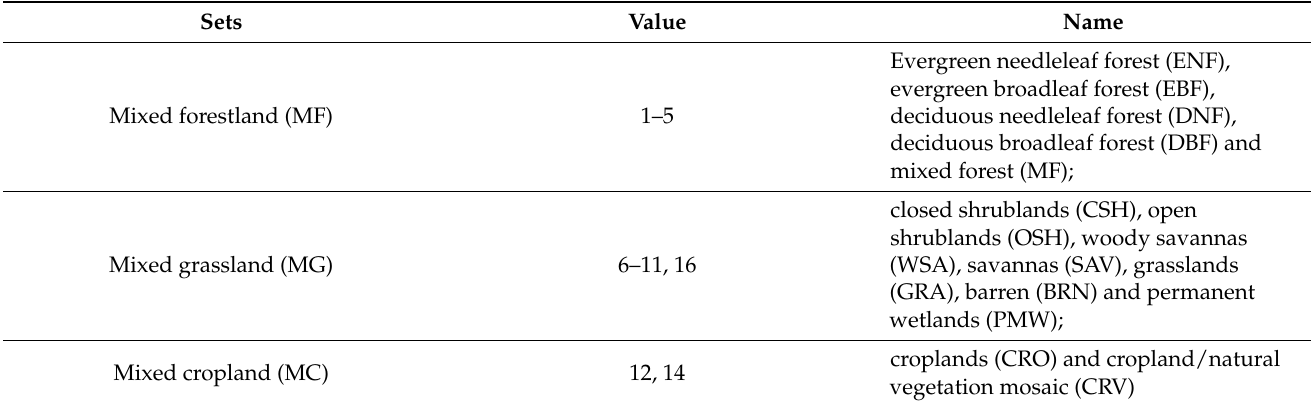
Table 1. Three major vegetation sets based on MCD12Q1 (IGBP)